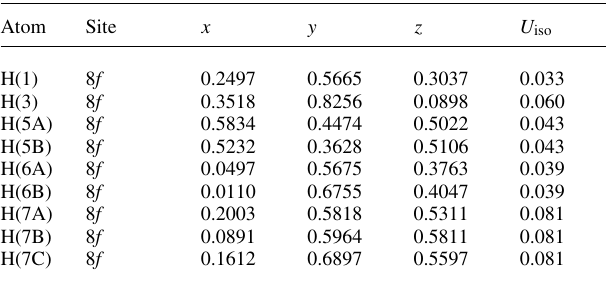
Table 2. Atomic coordinates and displacement parameters (in Å 2 )